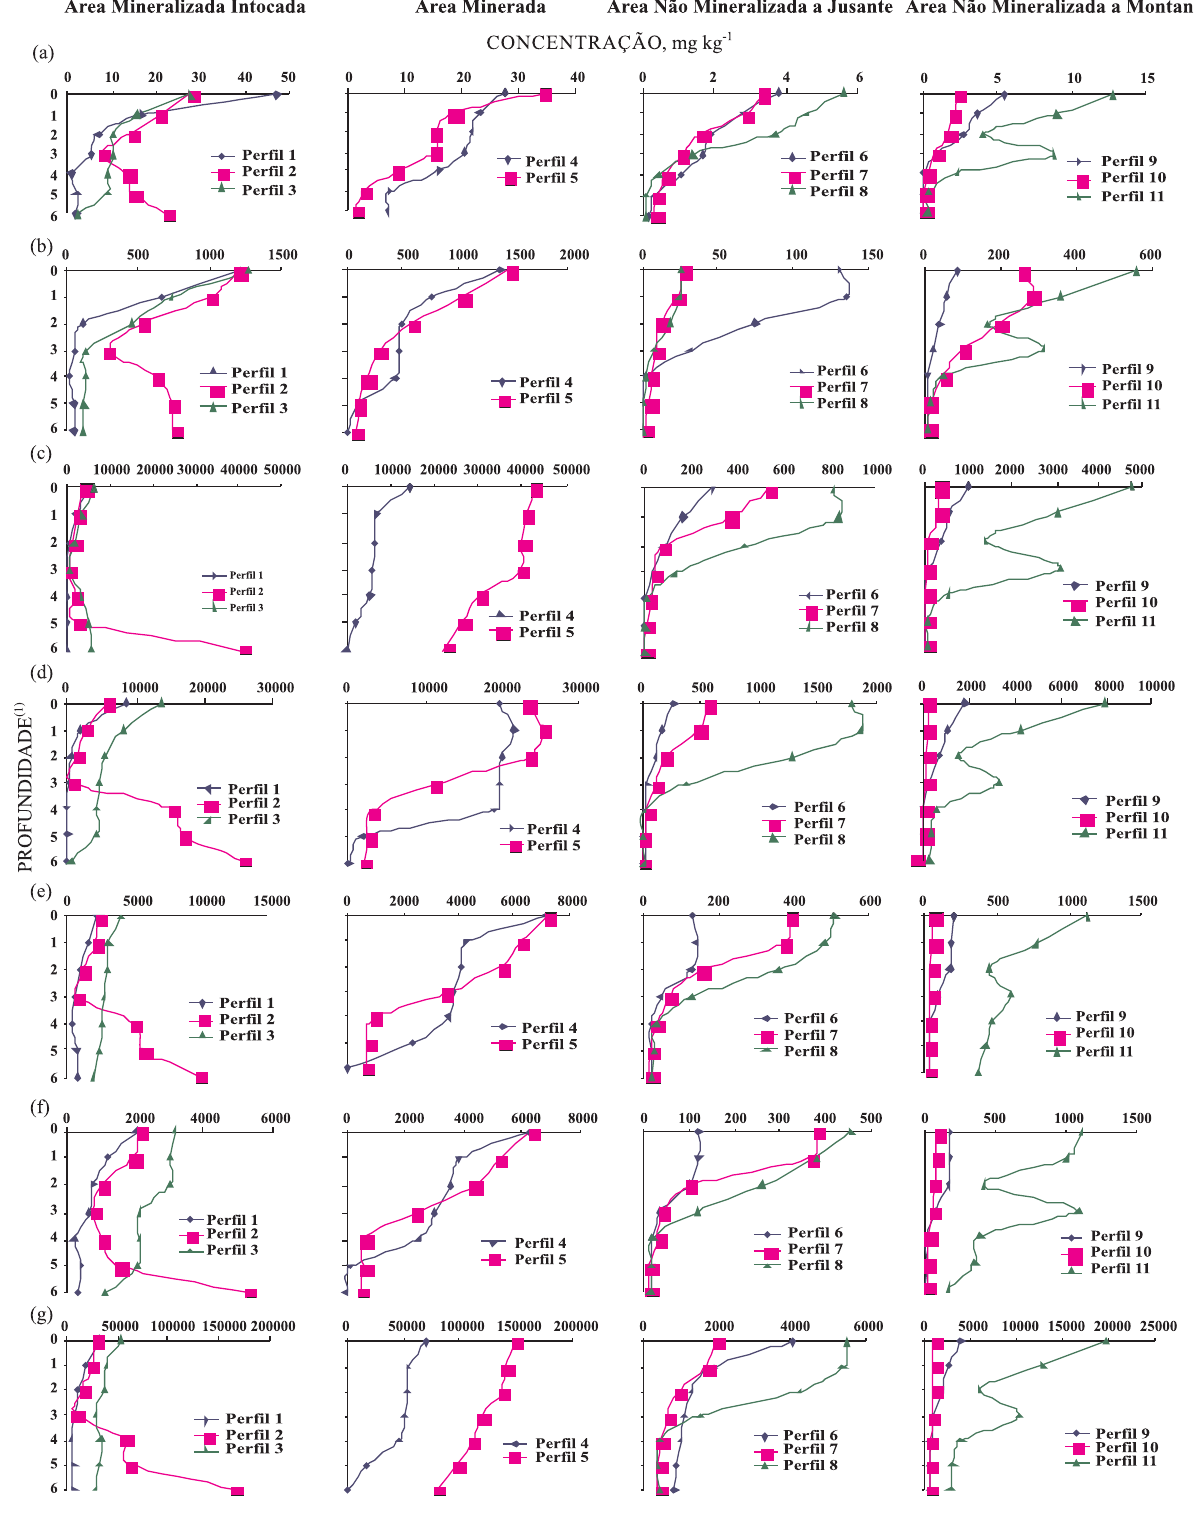
Figura 2. Teor de Zn em função da profundidade nos perfis de solos das áreas em estudo. (a) forma solúvel; (b) forma trocável; (c) forma associada a carbonato; (d) forma associada aos óxidos amorfos; (e) forma associada aos óxidos cristalinos; (f) forma associada à matéria orgânica; (g)